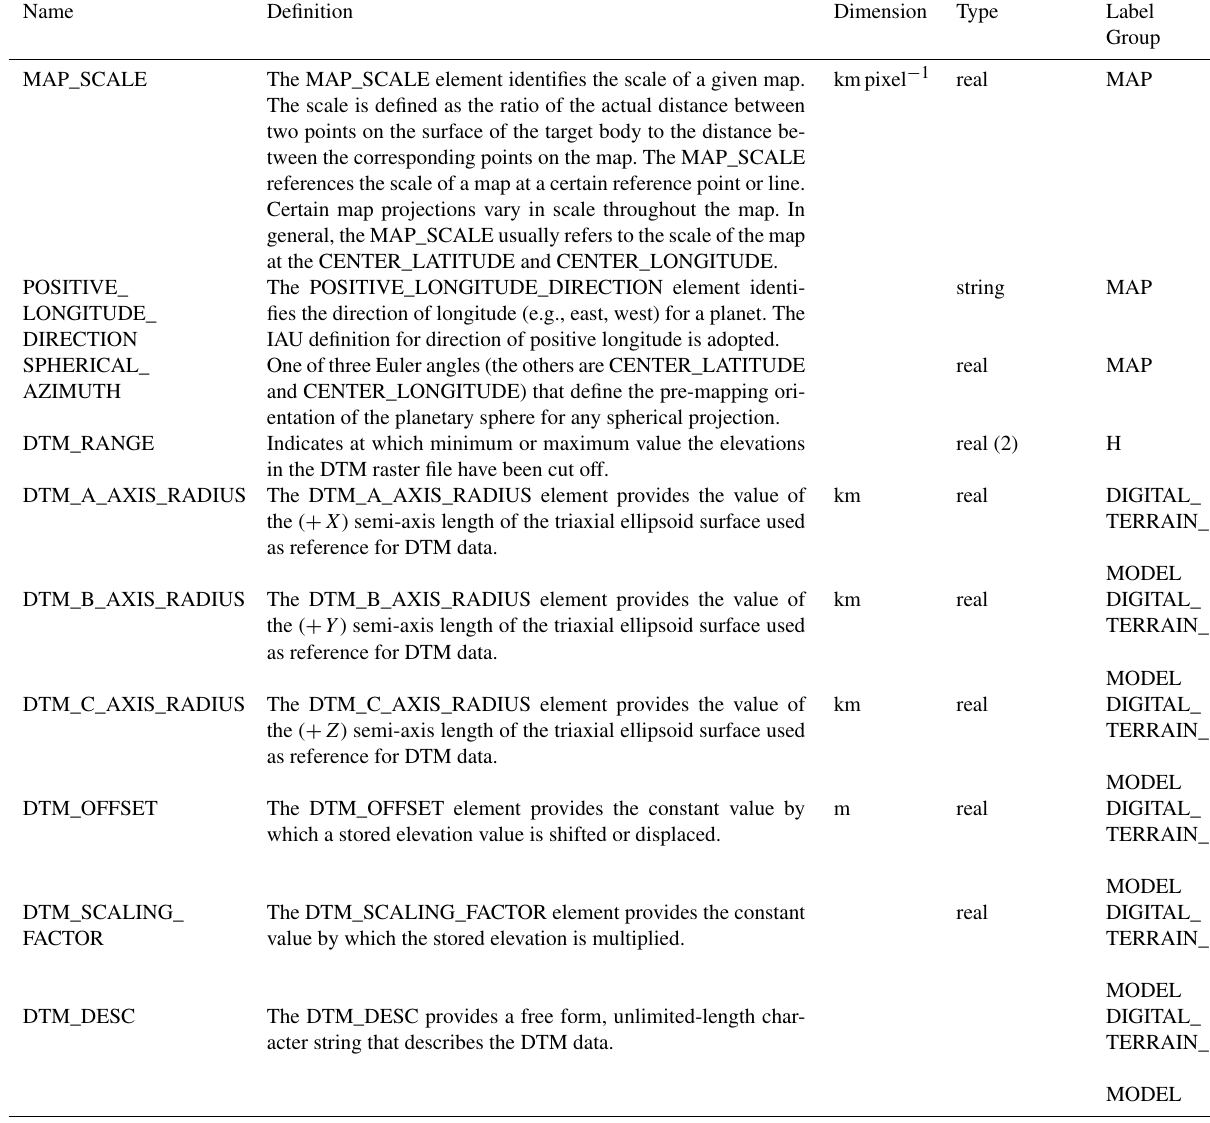
Table B2. Description of metadata (keyword-value pairs) contained in the HRSC-AX image